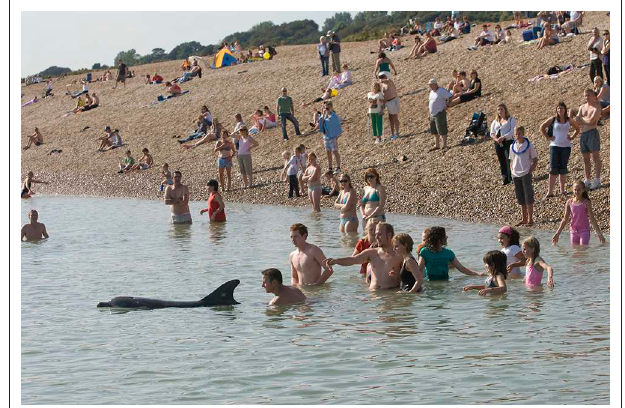
FIGURE 3 | Large numbers of people traveled to see “Dave” and to interact with her (Photo: Terry Whittaker).